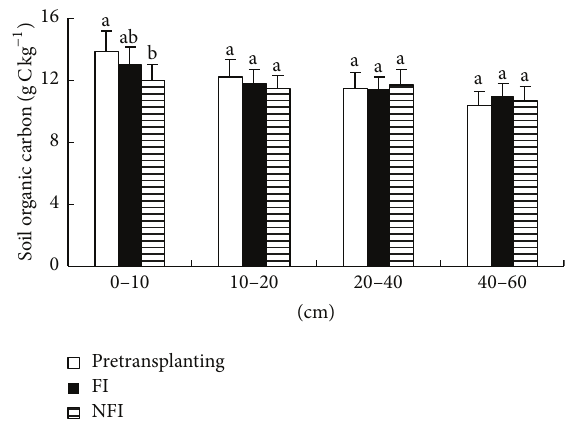
Figure 6: Soil organic carbon (SOC) contents in paddy soils under different irrigation management (pretransplanting means the SOC contents in soil before transplanting. Difference between the columns with the same letter in the same soil depth is not significant at 𝑃 < 0.05